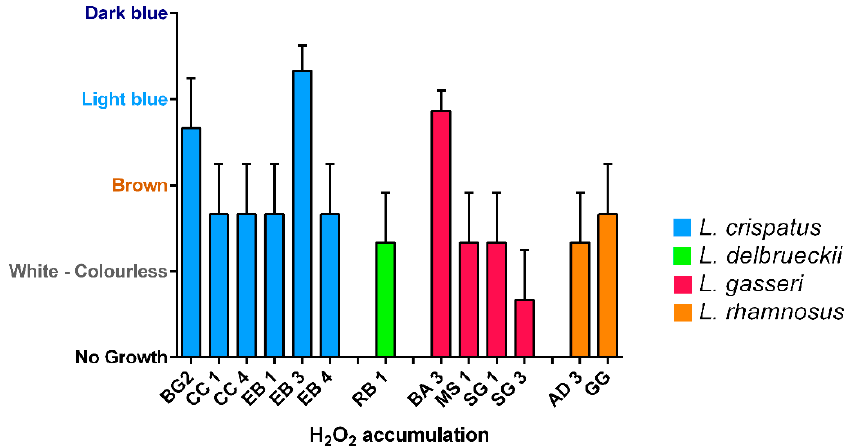
Figure 4. Hydrogen peroxide production of Lactobacillus isolates. White ‐ colorless: negative; Brown: slightly positive; Light blue: moderate; Dark blue: strong. Data are showed as mean ± SD.